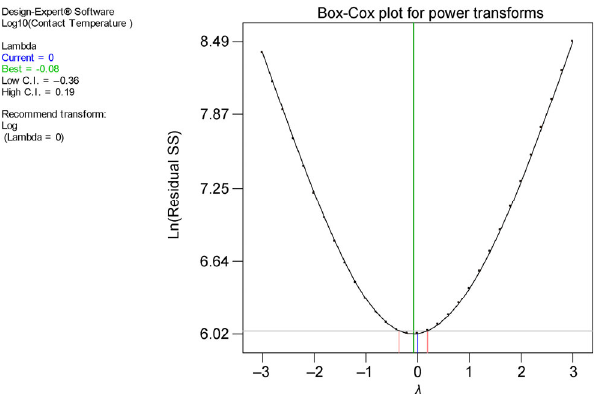
Fig. 16 Distribution of residuals over the experimentation run order for maximum contact temperature.